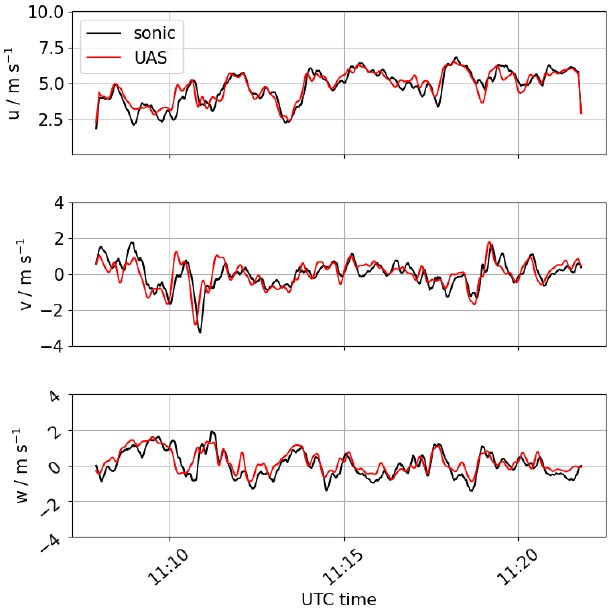
Figure 7. Example of time series of u , v , and w for a flight on 2 July 2021 by UAS#13. UAS data (red) are compared to the sonic anemometer at the same height